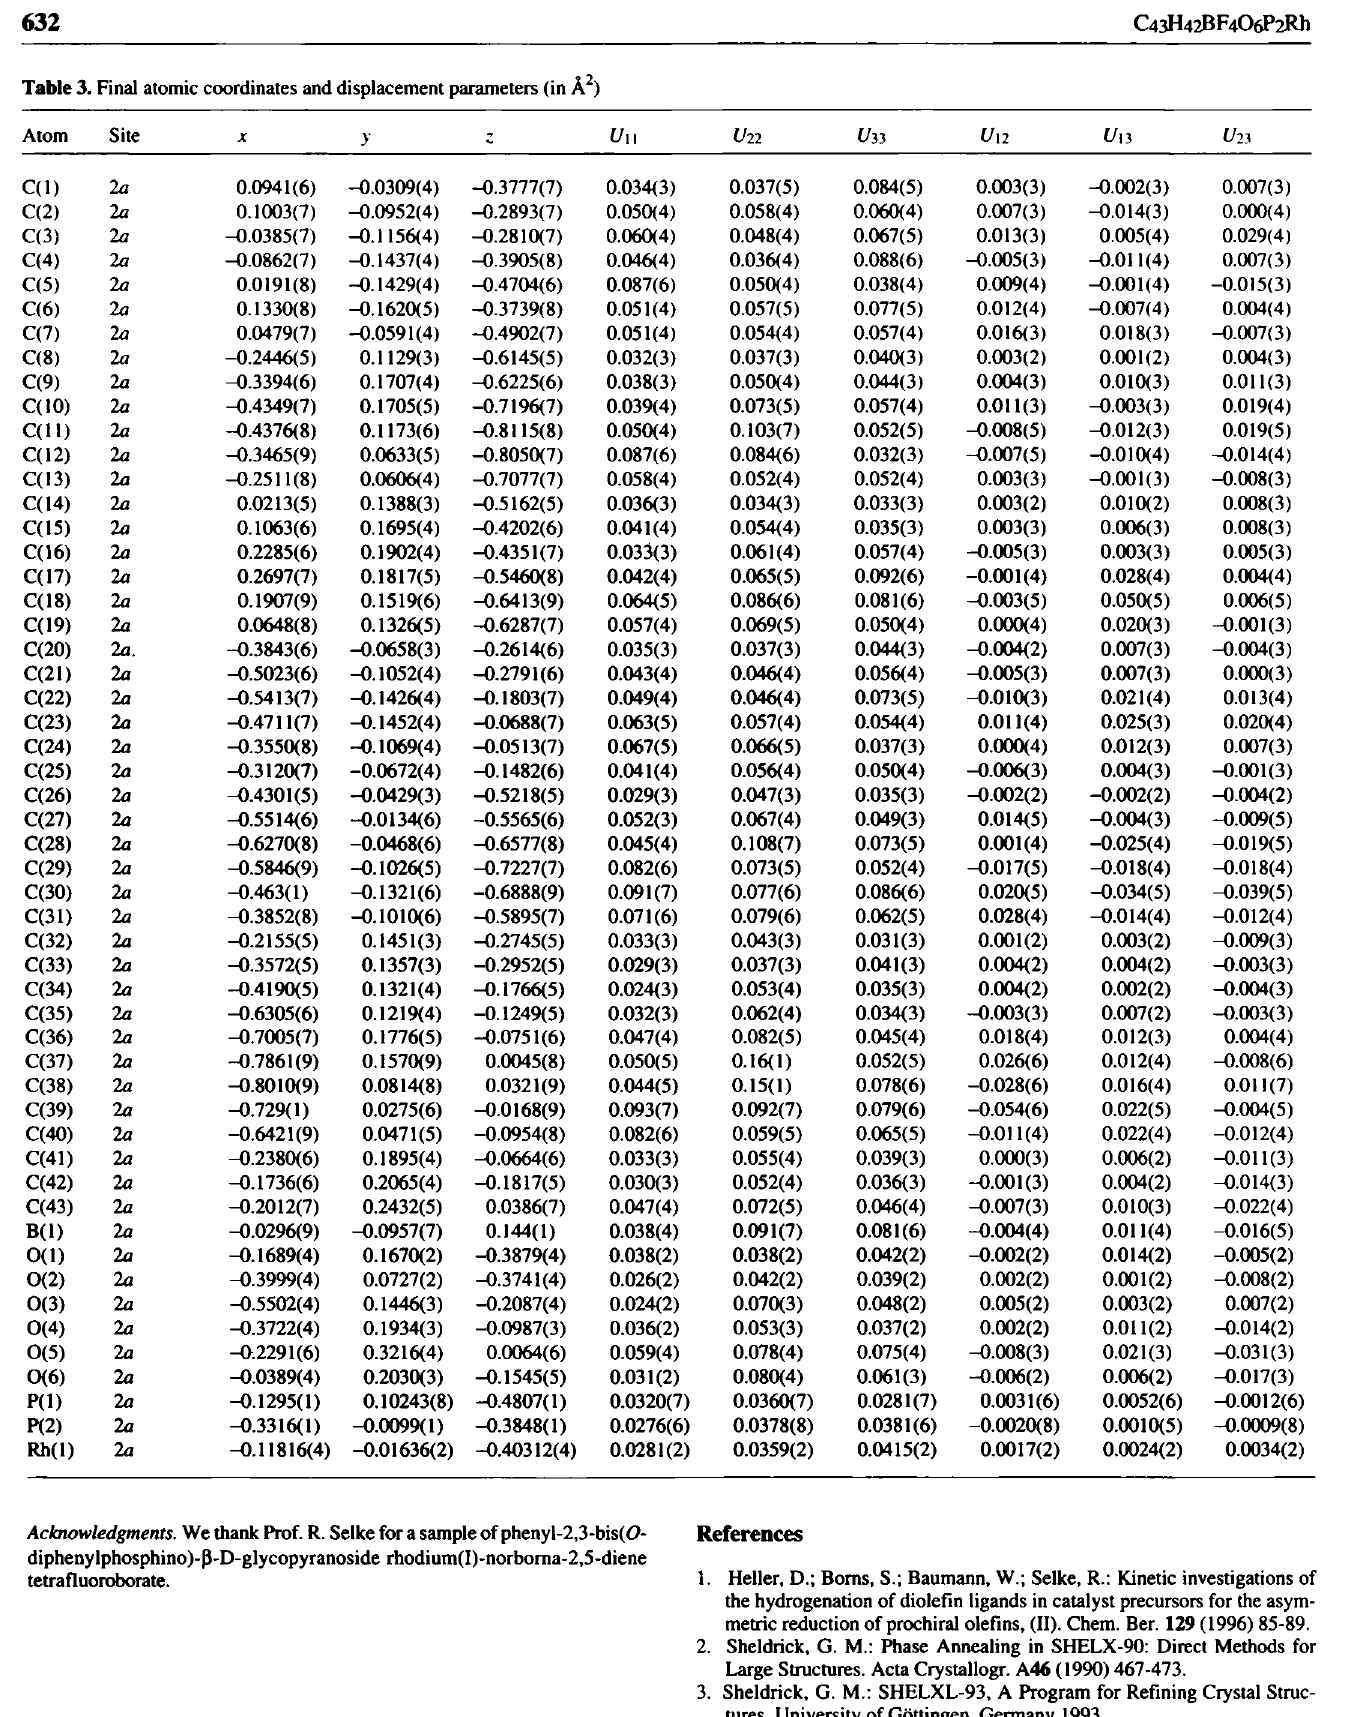
Table 3. Final atomic coordinates and displacement parameters (in